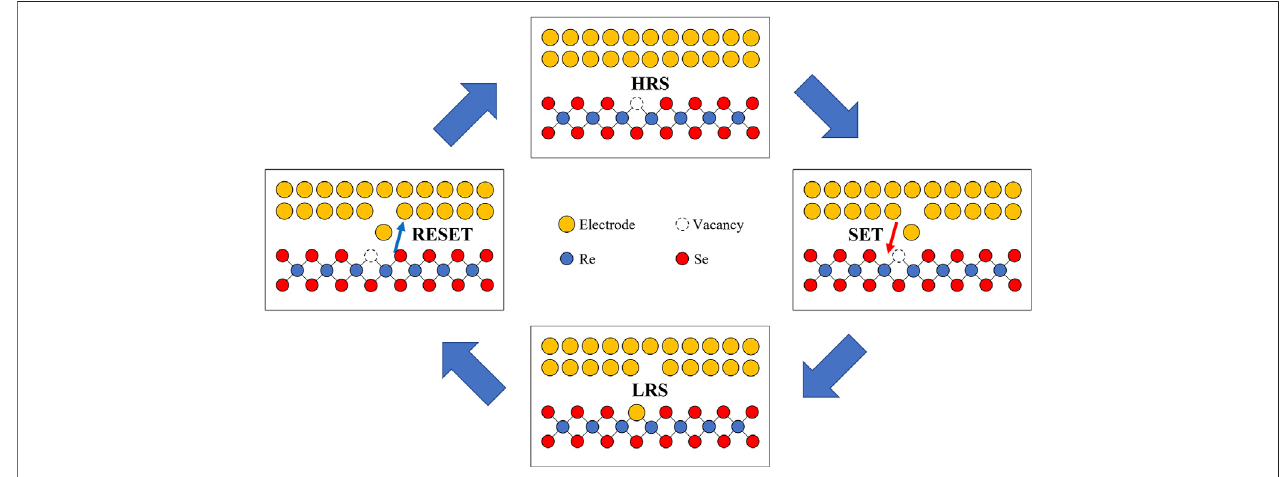
FIGURE 4 | Schematics of the conductive-point model with metal adsorption. Starting from HRS, Au ions or atoms from the electrodes will be driven by external voltage biasand diffuse toSevacancies in theactive layer (SET), leadingthedevice toLRS. While applying RESET voltage, the Auions oratoms willbe moved out ofthe vacancies by current-induced Joule heating effect, resulting in a transition to a higher resistance state.